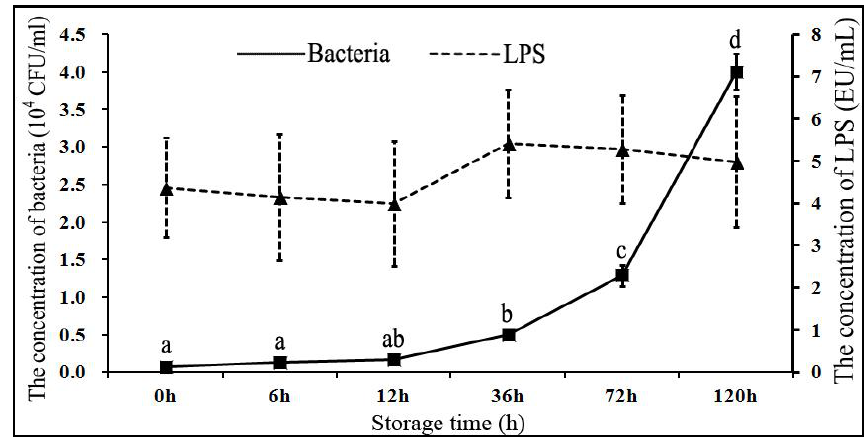
Figure 1. Changes in the concentration of bacterial colonies and lipopolysaccharide (LPS) in boar semen stored at 17 °C (liquid storage conditions). The values are presented as mean ± SE ( n = 5 pooled samples). a, b, c, d indicate significant differences ( p < 0.05).